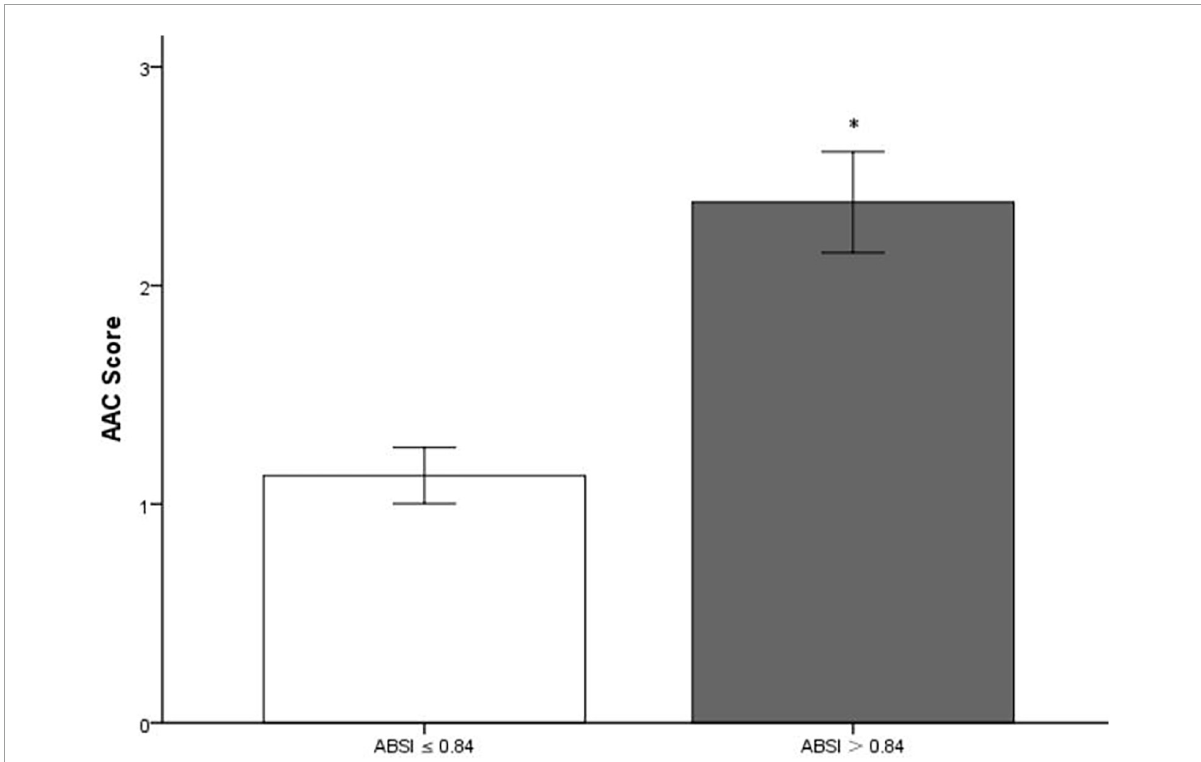
FIGURE3 Bar graph of mean value of AAC score stratified by a body shape index (ABSI). AAC, abdominal aortic calcification. *Compared with lower a body shape index (ABSI) group, participants in higher ABSI group had significantly higher AAC score ( P < 0.001).